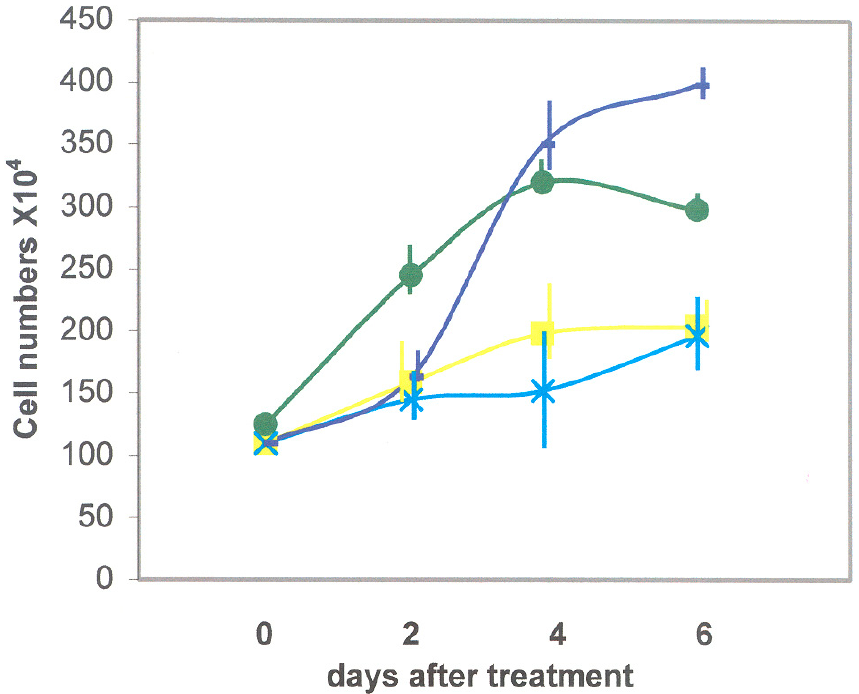
Figure 5. Effect of recombinant DSP/PP proteins on cell proliferation in rat dental pulp M2H4 cells. Dark blue line represents cells treated with sf9 conditioned medium containing anti-sense protein (no recombinant protein). Dark green represents cells treated with sf9 conditioned medium and ascorbic acid (50 μ g/mL). Yellow line represents cells treated with DSP/PP recombinant proteins. Light blue line represents cells treated with DSP/PP recombinant proteins and ascorbic acid (50 μ g/mL). Error bars represent S.E. (n=3).